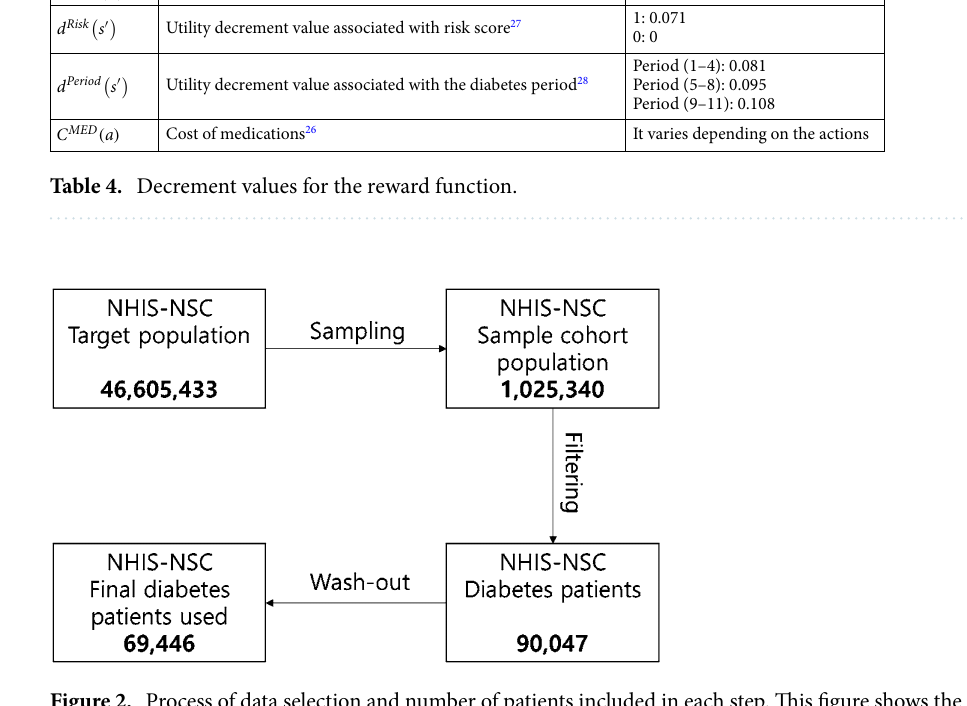
Figure 2. Process of data selection and number of patients included in each step. This figure shows the process of data cleansing for